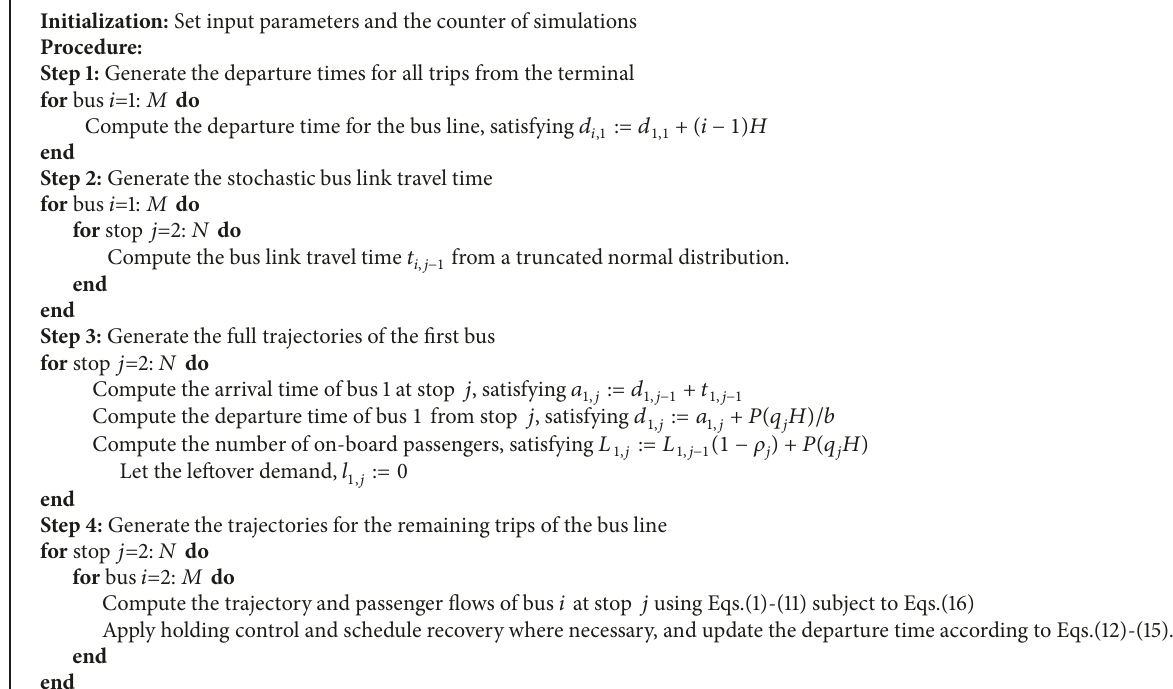
Algorithm 1: Bus trajectories evolution